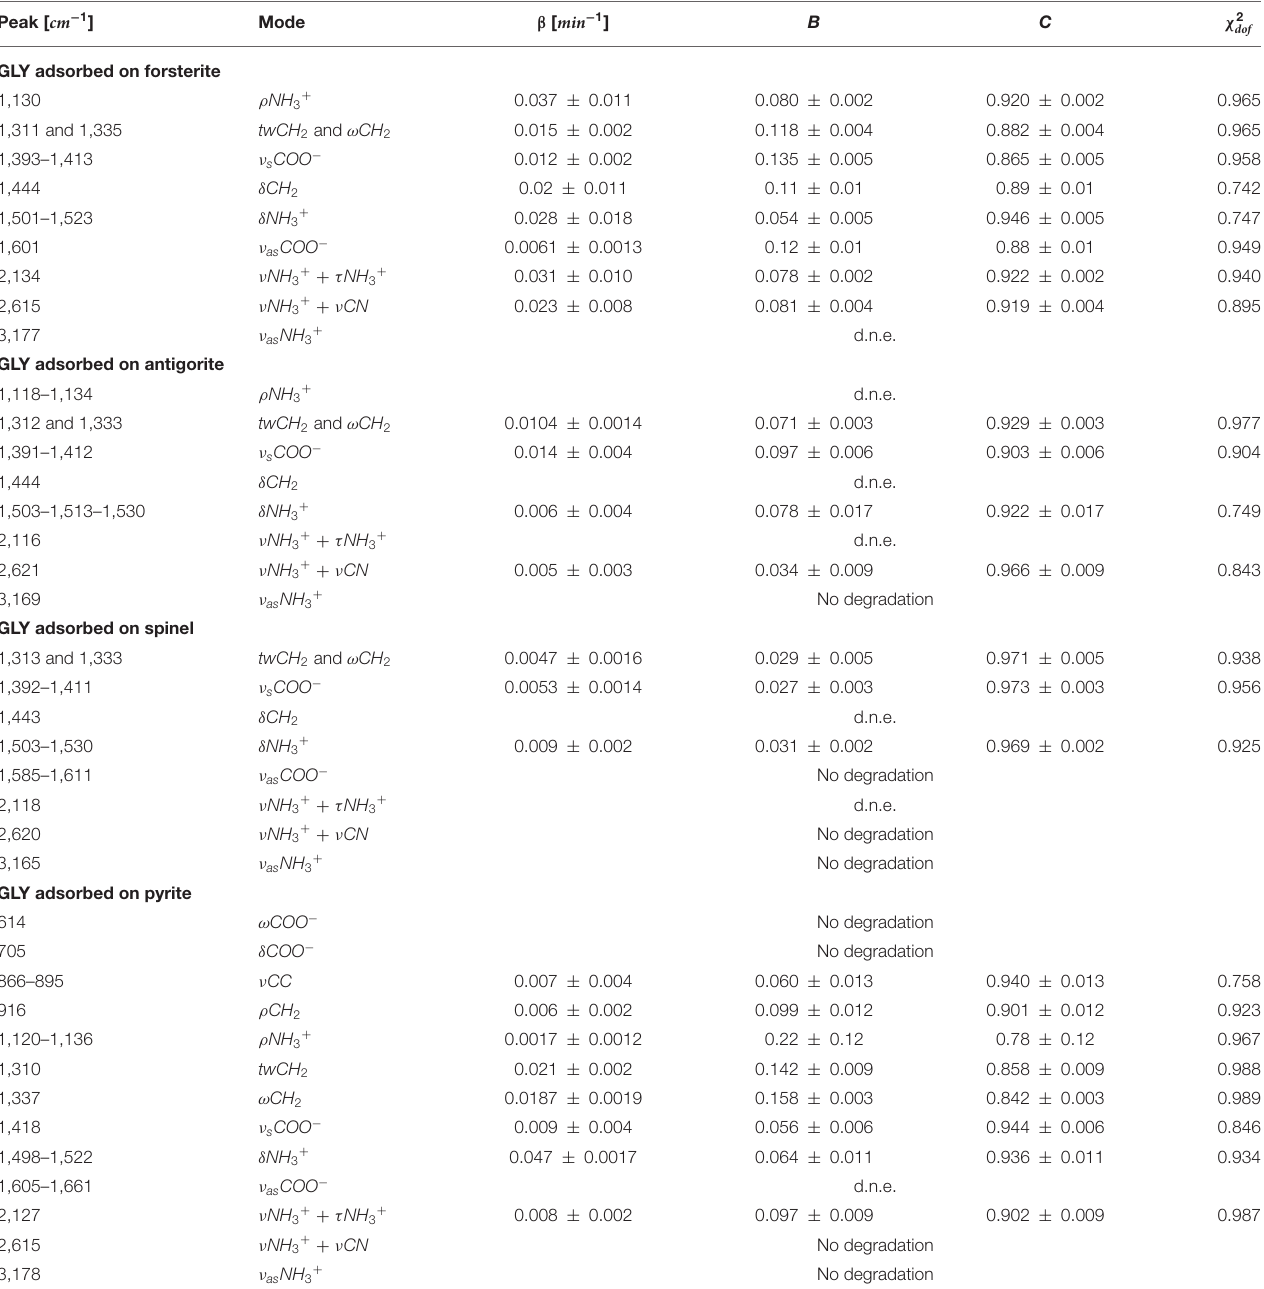
TABLE 5 | Best-fit values of the degradation rate β , the fraction of molecules that interact with UV radiation B , and the fraction of molecules that do not interact with UV radiation C , for GLY adsorbed on minerals UV irradiated in laboratory conditions. Peak [ cm − 1